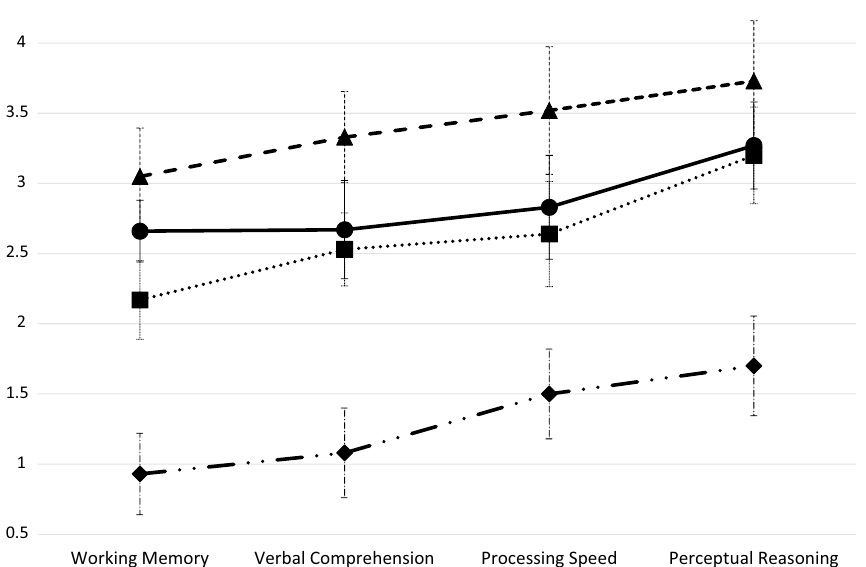
Figure 2. Marginal means of Wechsler intelligence indices associated with latent class membership, children with and without neurodevelopmental disorders, Mexico City,